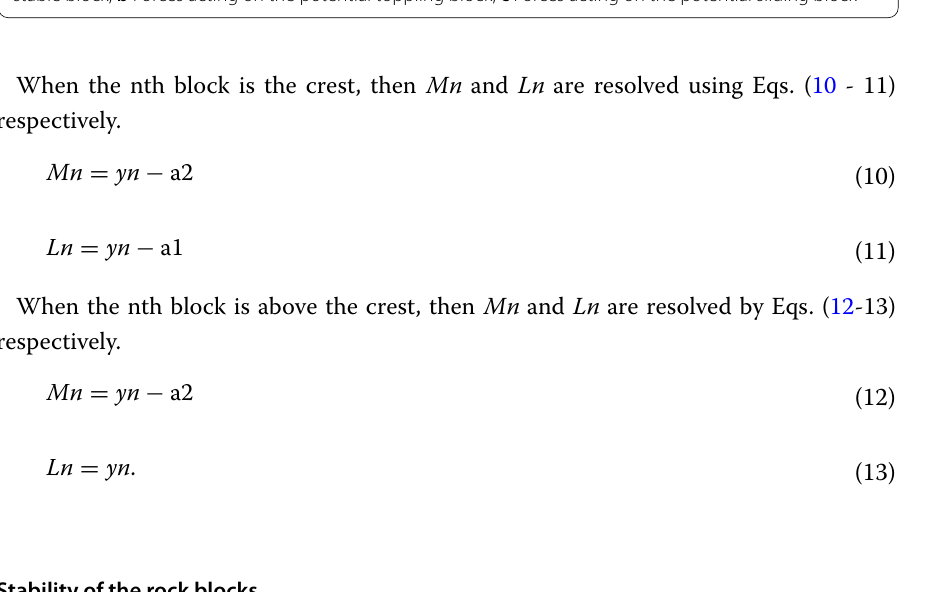
Fig. 4 Limiting equilibrium conditions for failure modes of the nth block: a Forces acting on the potential stable block; b Forces acting on the potential toppling block; c Forces acting on the potential sliding